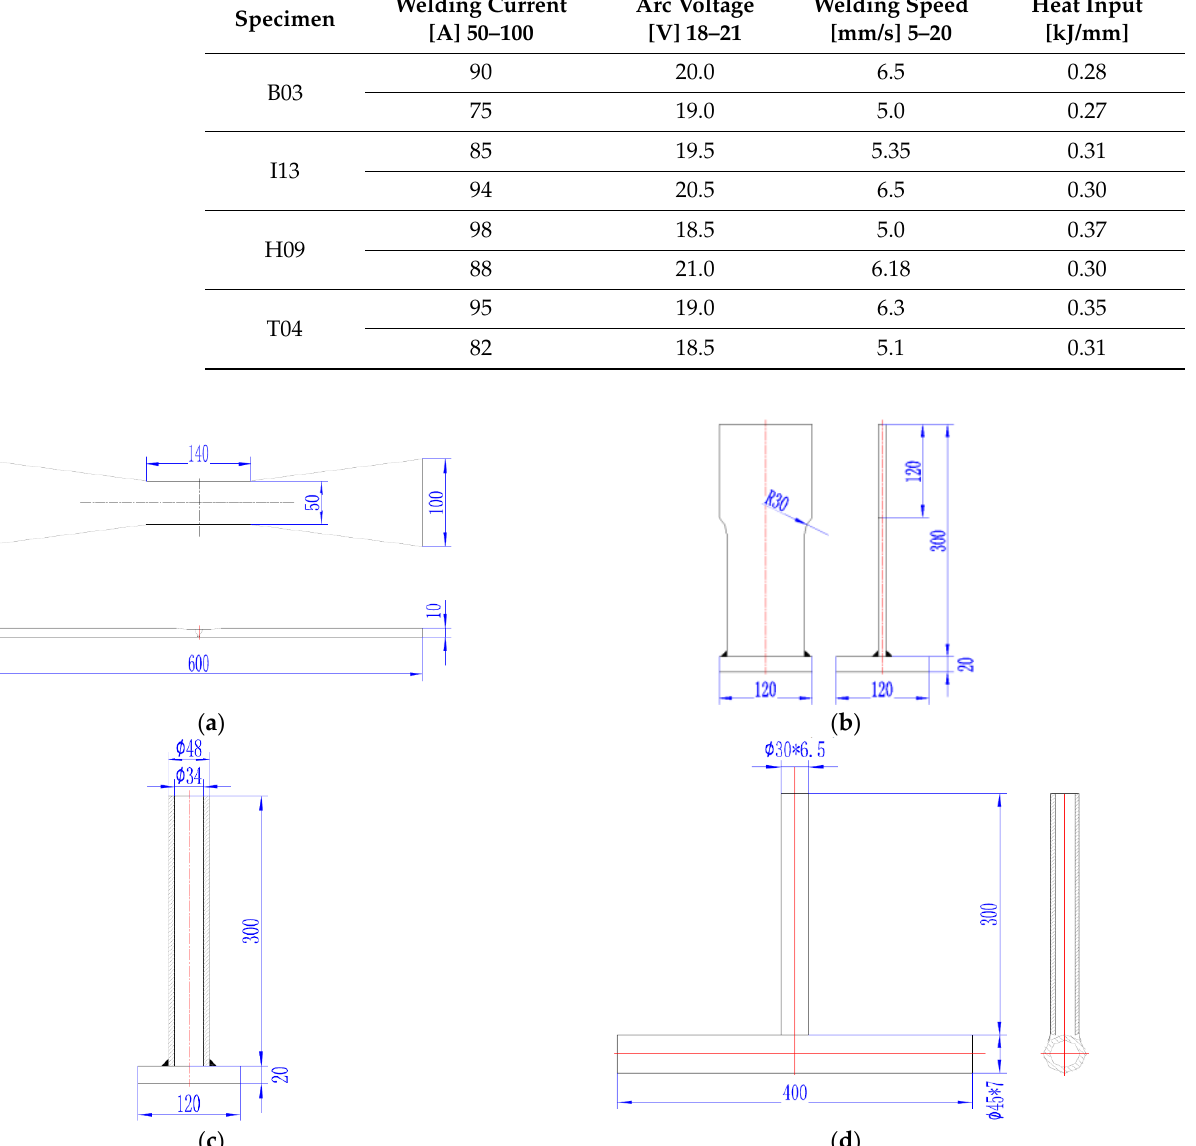
Figure 3. Geometric structure of the specimen used in laboratory measurements (in mm) ( a ) Welded steel plates (B03), ( b ) T-type welded steel plates (I13), ( c ) combination of plate and pipe (H09), and ( d ) combination of two steel pipes (T04). Table 1. Material properties of specimens [78–80].